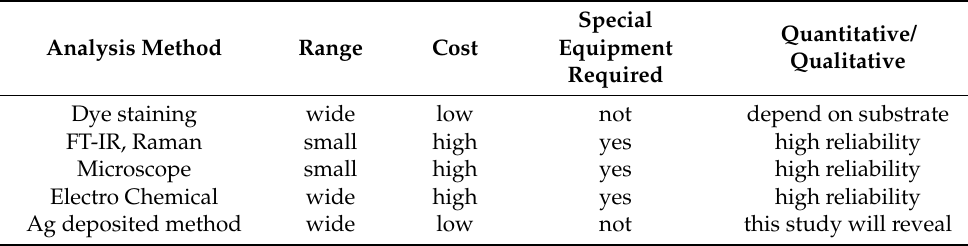
Table 1. The characteristics of each analytical evaluation